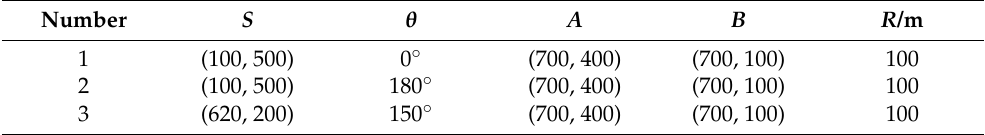
Table 3. Test points chosen for comparison.